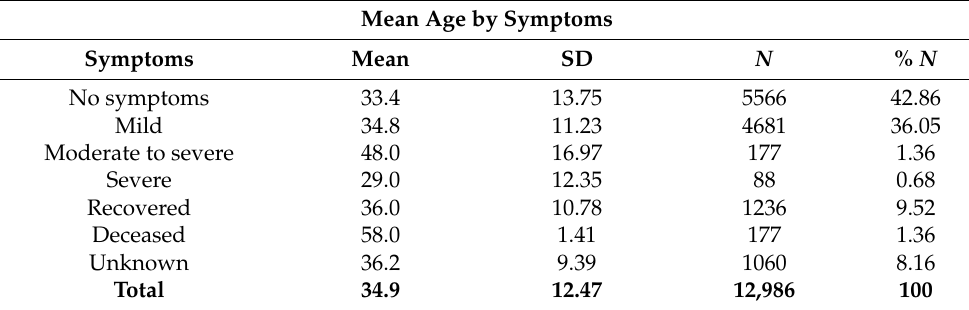
Table 3. Mean age by